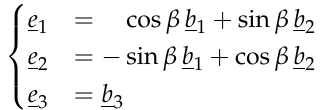
Table 1. Cycloidal and screw propeller non-dimensional coefficients. Coefficients Cycloidal Screw advance coefficient λ = V A thrust coefficient K S = T torque coefficient